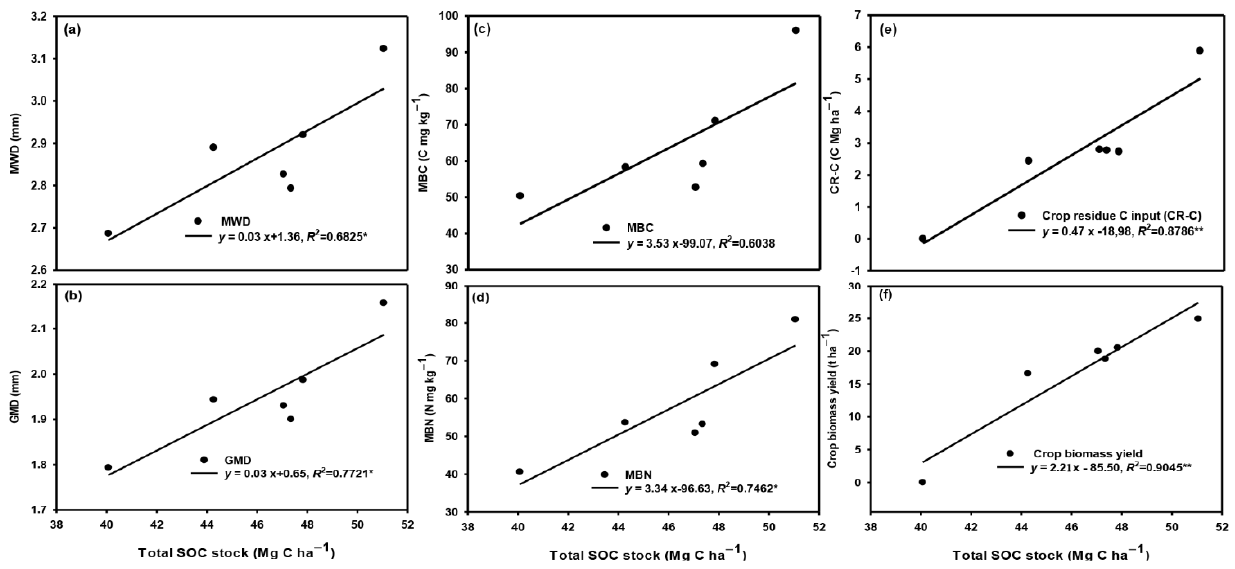
Figure 4. Correlation between the total SOC inventory and ( a ) the MWD, ( b ) GMD, ( c ) MBC, ( d ) MBN, ( e ) C use of crop residues (CR-C), and ( f ) total biomass yield. Linear regressions were performed using SPSS 19.0 software (IBM SPSS, Armonk, NY, USA). The graphs were generated using SigmaPlot 14.0 (Systat Software, Inc. Palo Alto, CA, USA). Significant differences were assessed by LSD testing at p < 0.05, * and ** were the significance at 0.05 and 0.01.